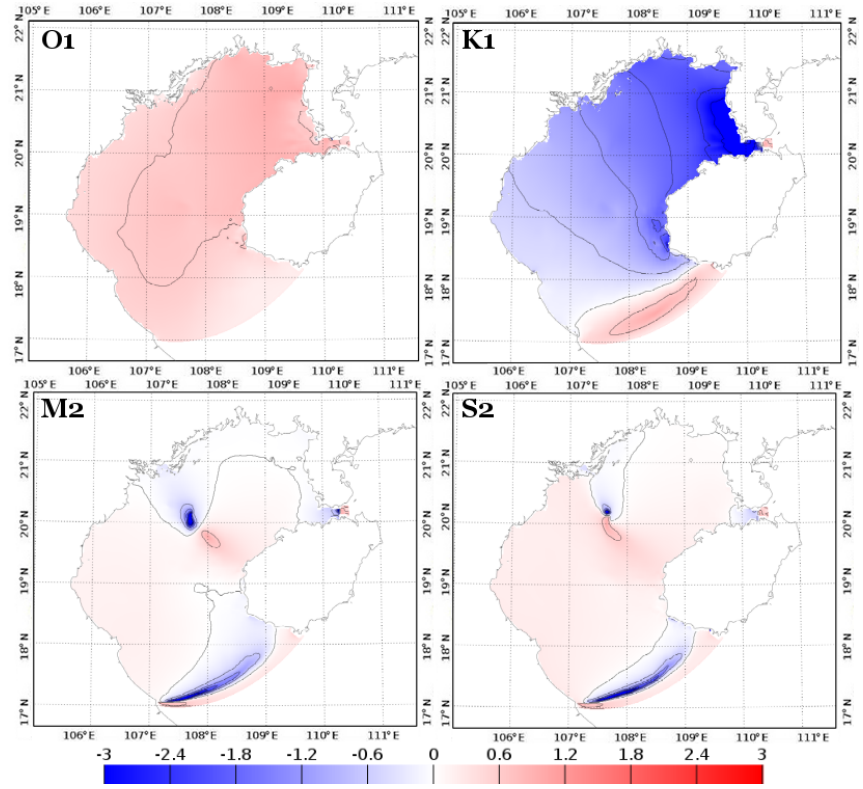
Figure 15. Relative differences (in percent) between simulation Test 6 and simulation with C D = f (z 0 = 1 . 5 × 10 − 5 ,H ) compared to FES2014b-with-assimilation (as a reference) for the tidal harmonics of O 1 , K 1 , M 2 , and S 2 .